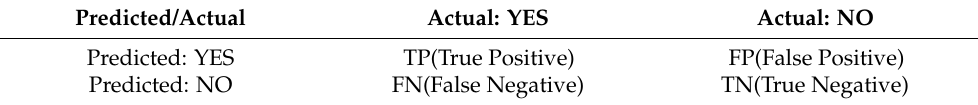
Table 2. The confusion